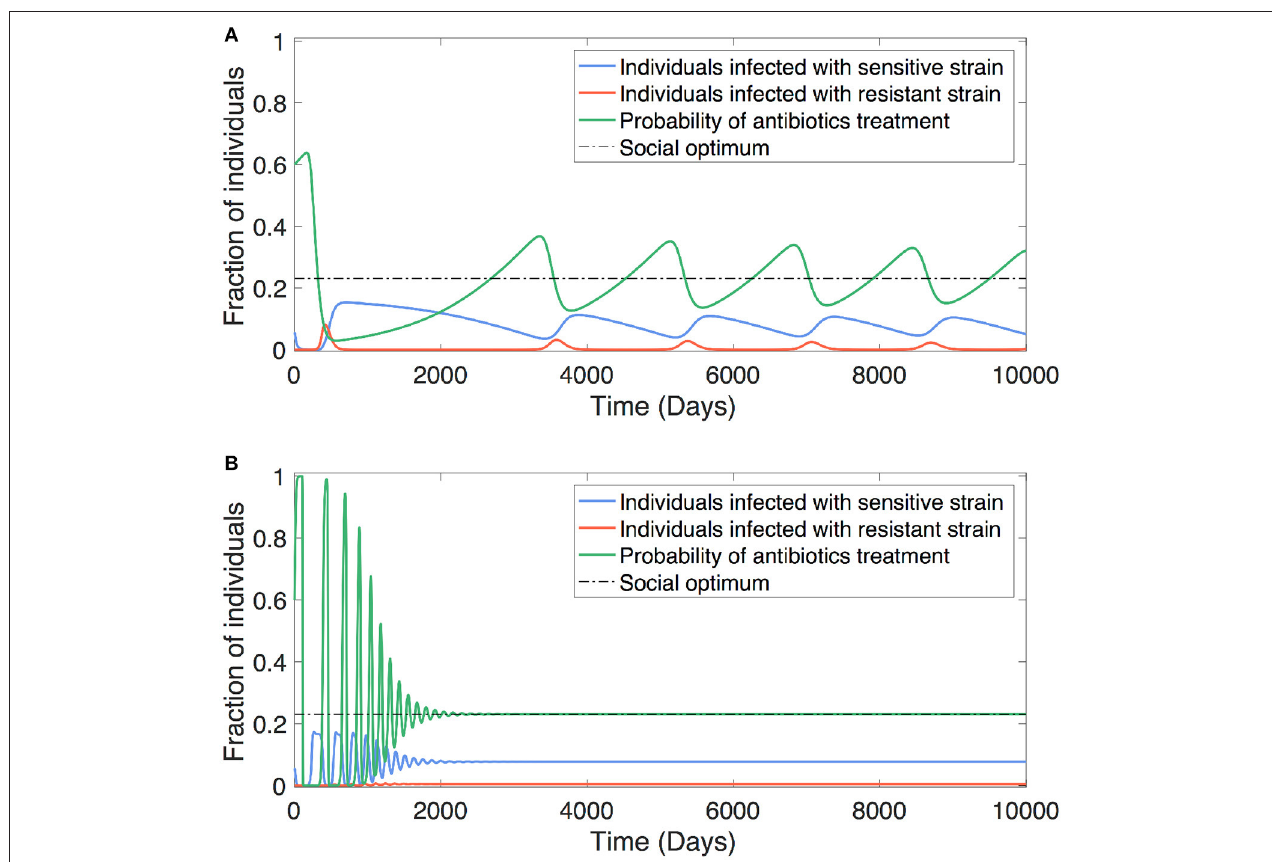
FIGURE 4 | Social learning impacts antibiotic usage. The antibiotic usage behavior can be adjusted in response to the underlying dynamics of resistance evolution. The convergence of optimum antibiotic usage is determined by how promptly the society learns from the collective consequences of treatment decisions and costs that are associated with resistance. (A) Slow learning leads to oscillatory dynamics of antibiotic usage (between overuse and lesser use) together with alternating dominance of resistant and sensitive strains. (B) Fast learning can steer out cyclic oscillations of antibiotic usage due to overcorrection, and therefore helps the society quickly reach socially optimal usage. Parameters: b = 0.1, β s = 0.3, β m = 0.26, γ 0 s = γ 0 m = 0.1, γ t s = 0.3, γ t m = 0.2, ǫ s = 1, ǫ m = 0, θ = 0.2, µ s = µ m = 10 − 6 , relative social burden of the disease: